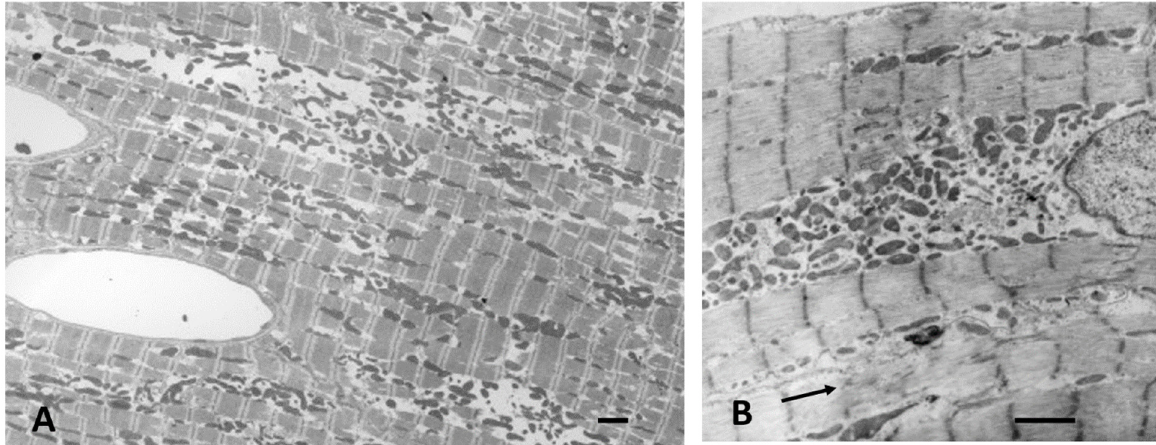
Figure 8. Electron micrographs of dilated LV from dogs with chronic mitral regurgitation and congestive heart failure. ( A ) There are many small mitochondria and focal distortions of myofibrils and sarcomeres in ( B ) (arrow). Bar = 2 µm in each.